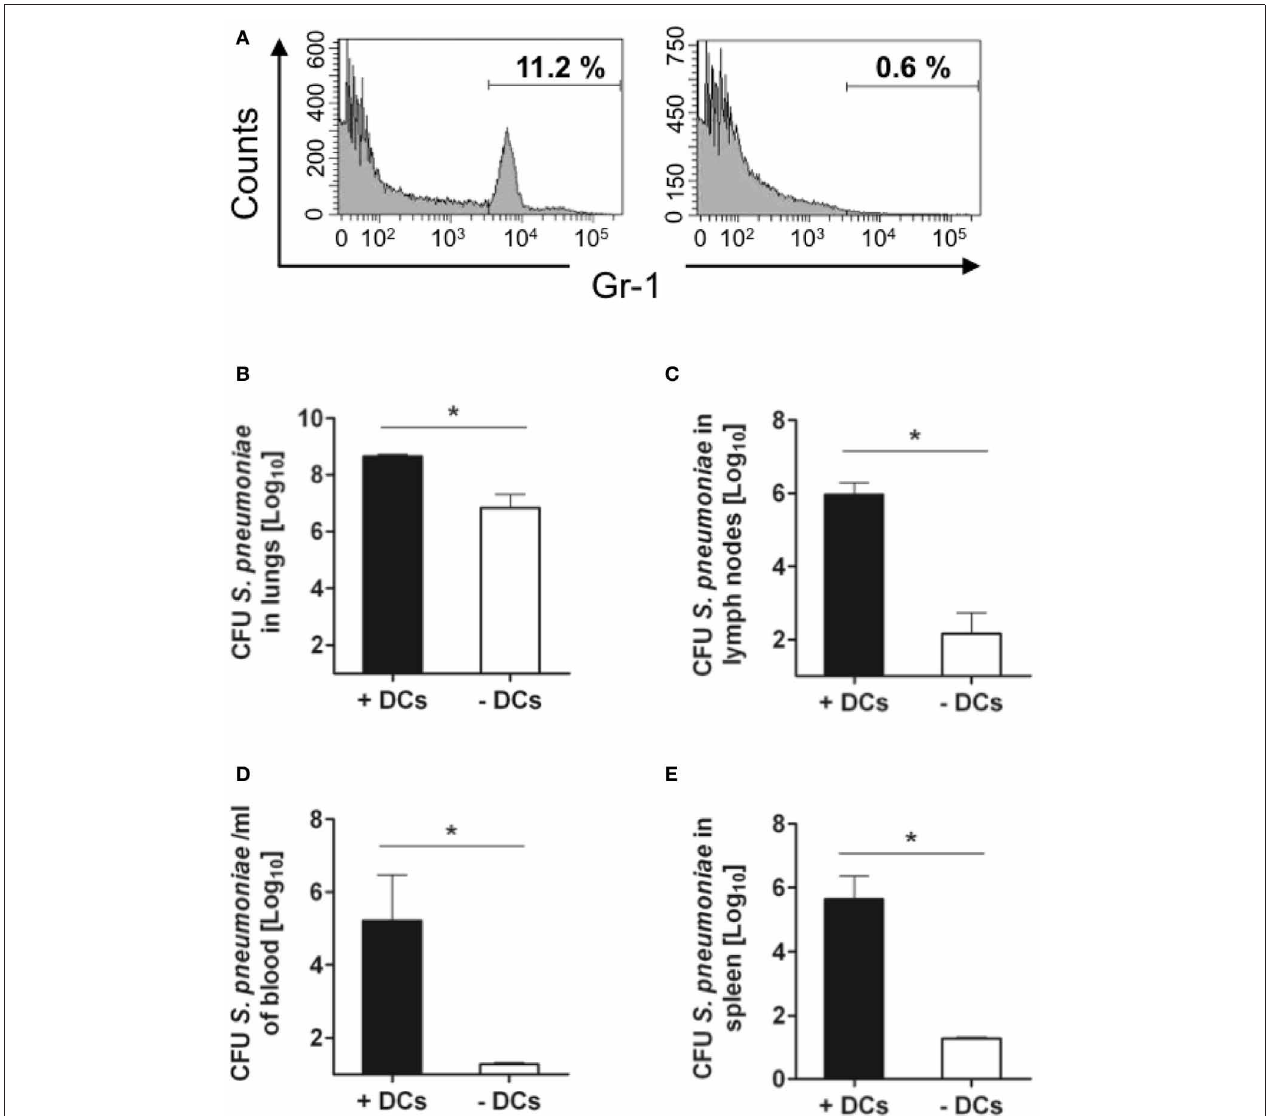
FIGURE 5 | Effect of neutrophil depletion in control of S. pneumoniae by DCs-depleted and non-depleted mice. DT-treated (white bars) and untreated (black bars) CD11c-DTR chimera mice were depleted of neutrophils and intranasally infected with 1 × 10 8 CFU of S. pneumoniae D39. (A) Histograms showing the percentage of neutrophils in blood